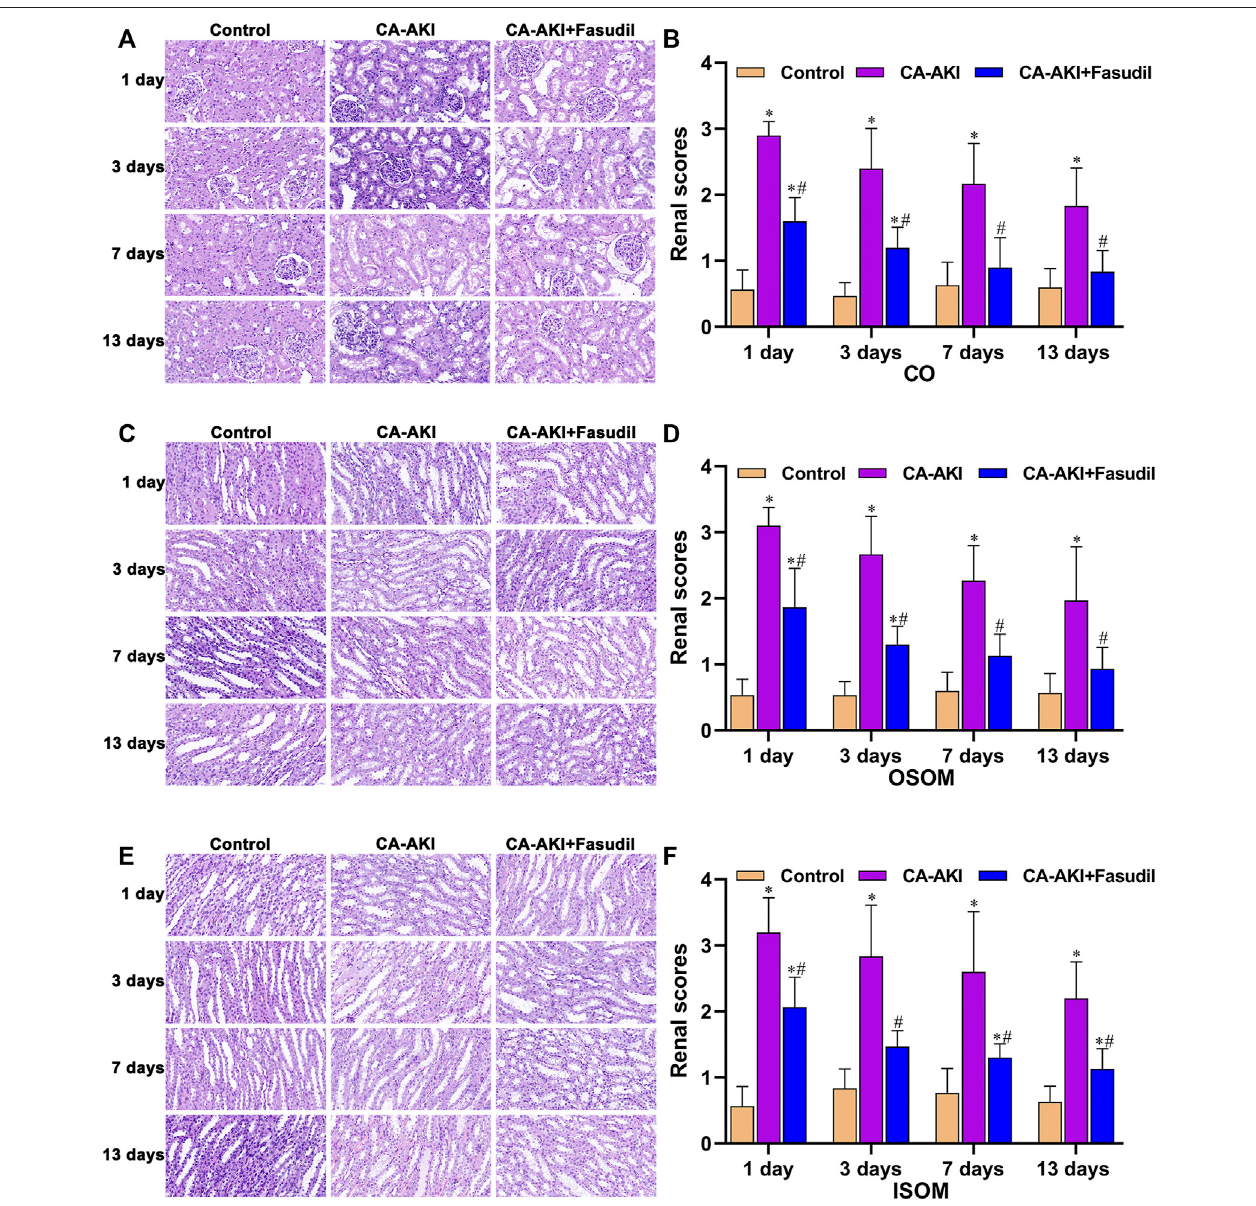
FIGURE6| Renalhistopathologyinthreeanimalgroups: (A) microscopicviewsofglomerularandtubularinjuryatCO; (B) histologicscoresatCO; (C) microscopic viewsoftubularinjuryatOSOM; (D) histologicscoresatOSOM; (E) microscopicviewsoftubularinjuryatISOM;and (F) histologicscoresatISOM.* p < 0.05betweenCA- AKI/CA-AKI + Fasudil and controls; # p < 0.05 between CA-AKI + Fasudil and CA-AKI. CA-AKI: contrast-associated acute kidney injury; ISOM: inner stripe of the outer medulla; CO: cortex; OSOM: outer stripe of the outer medulla.